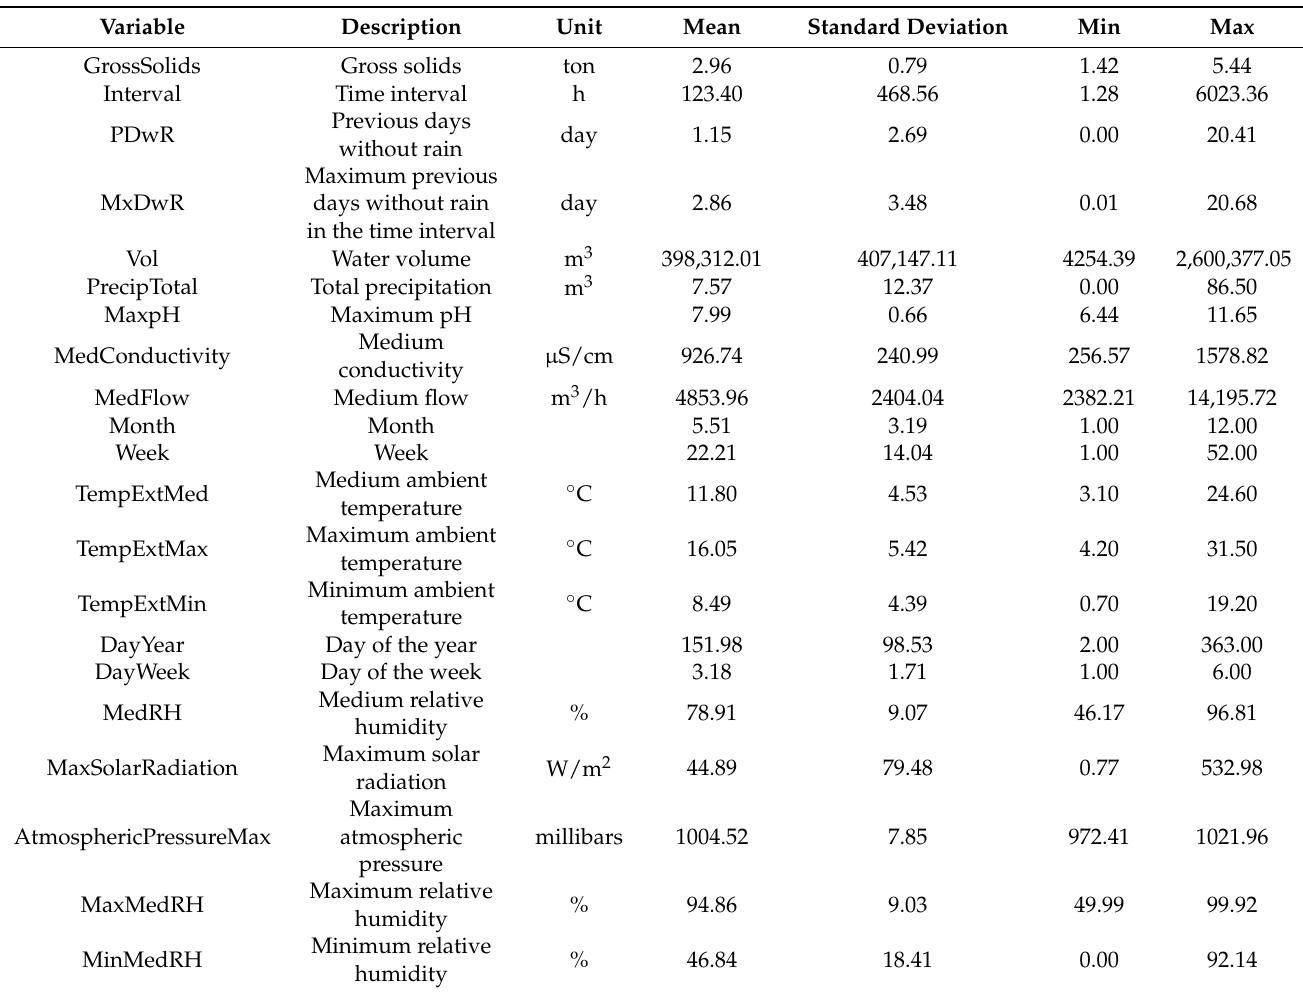
Table 3. Statistical description of the